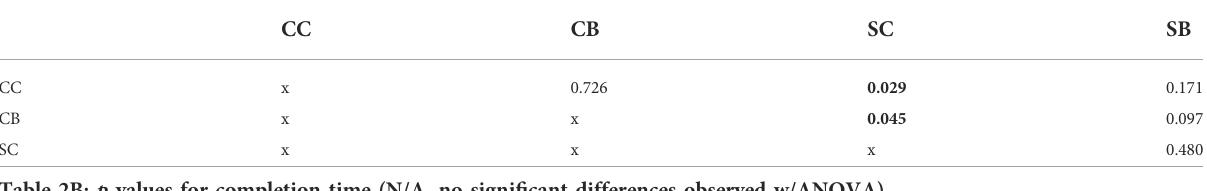
Table 2B: p -values for completion time (N/A, no signi fi cant differences observed